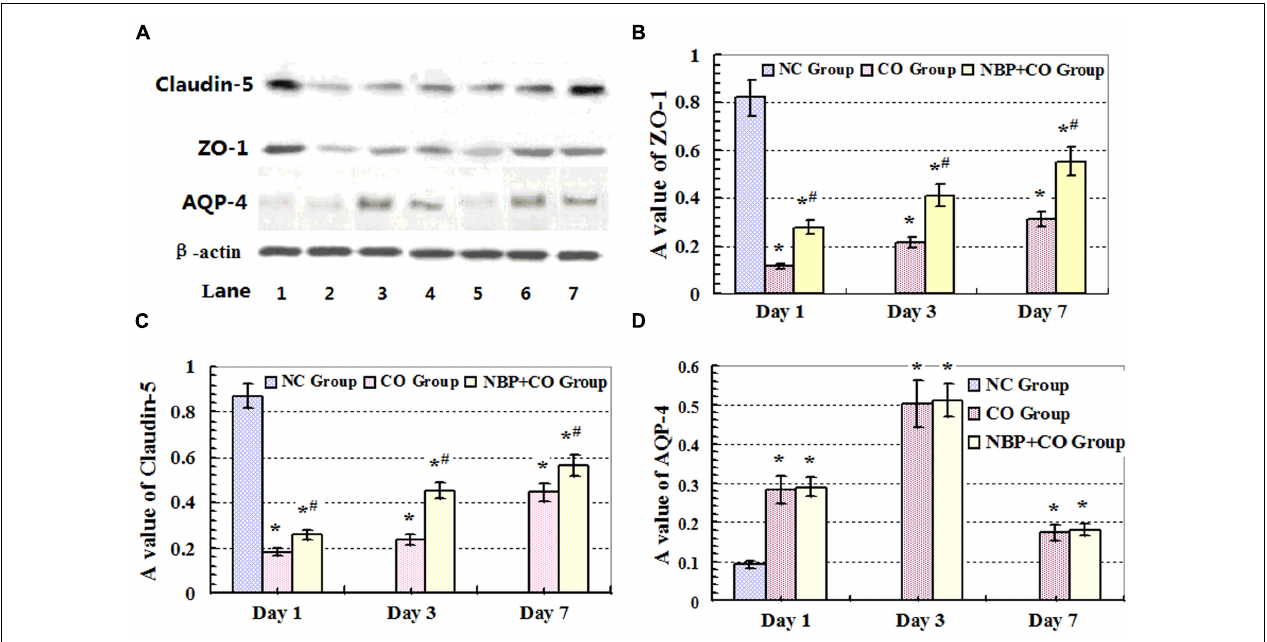
FIGURE 5 | Expressions of ZO-1, claudin-5 and AQP-4 proteins analyzed by Western blot. High expression levels of ZO-1 and claudin-5 proteins were observed in rat brain tissue in NC group. CO poisoning can markedly decrease the expressions of ZO-1 and claudin-5 proteins both in CO group and NBP + CO group at early stage after exposure to CO. By contrast, NBP administration can significantly increase the levels of both ZO-1 and claudin-5 target proteins compared with those in CO group at the same time ( n = 4, P < 0.05). (A) The expressions of ZO-1, claudin-5, AQP-4 and β -actin proteins by Western Blot assay. Lane 1: NC group; Lane 2: day 1 in CO group; Lane 3: day 3 in CO group; Lane 4: day 7 in CO group; Lane 5: day 1 in NBP + CO group; Lane 6: day 3 in NBP + CO group; Lane 7: day 7 in NBP + CO group. (B) The relative A values of ZO-1 protein; (C) The relative A values of claudin-5 protein; (D) The relative A values of AQP-4 protein. ∗ Compared with NC group, P < 0.05; # compared with CO group at the same time point, P < 0.05 ( F = 11.989 ∼